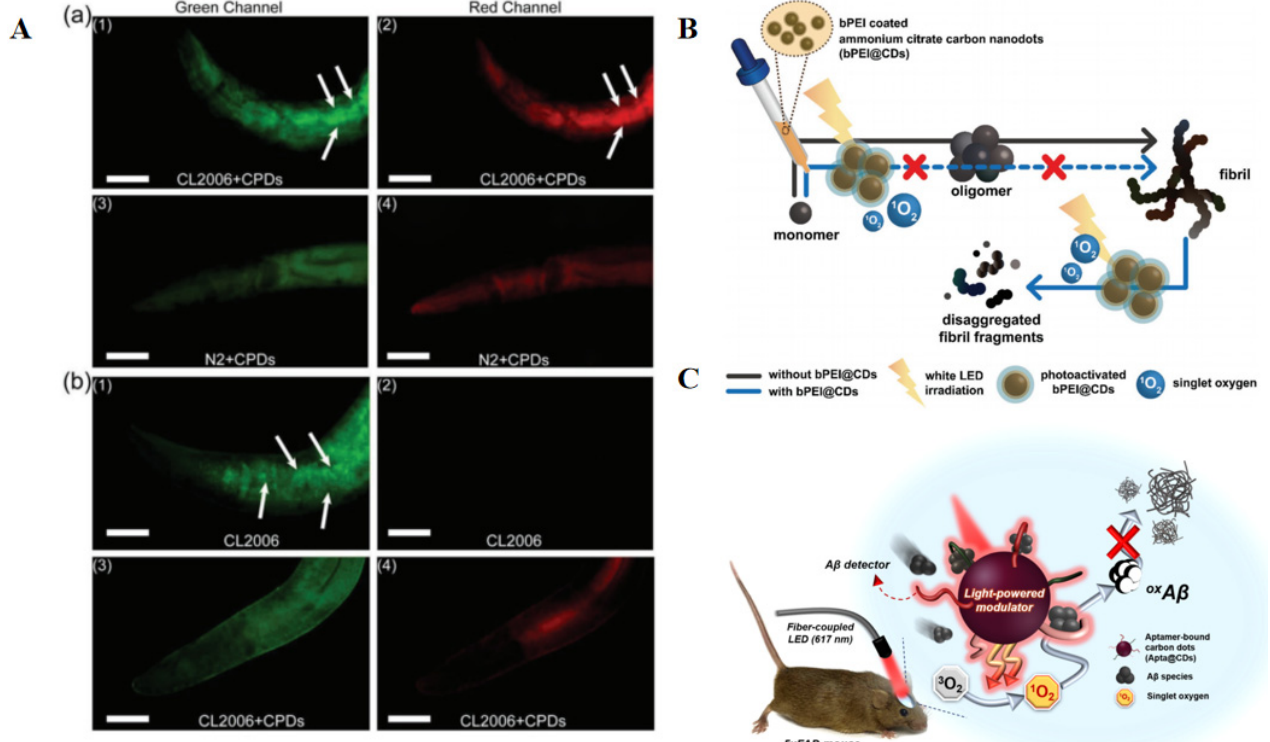
Figure 6. ( A ) In vivo assays with C. elegans (CL2006 and N2). (a) Fluorescence images of CL2006 (a1,a2) and N2 (a3,a4) nematodes that were co-stained with ThT and CPDs. (b) Fluorescent images of inhibiting A β deposits after treating without (b1,b2) or with (b3,b4) CPDs in CL2006 nematodes. Reprinted with permission from reference [101]. Copyright 2020 Wiley- VCH. ( B ) Schematic of bPEI@CDs’ capabilities regarding inhibiting A β assembly and disaggregating preformed fibrillar aggregates. Reprinted with permission from reference [102]. Copyright 2017 Wiley-VCH. ( C ) Schematic of A β -targeting, CD-mediated photomodulation modality for the spatiotemporal inhibition of A β aggregation in vivo. Reprinted with permission from reference [103]. Copyright 2020 American Chemical